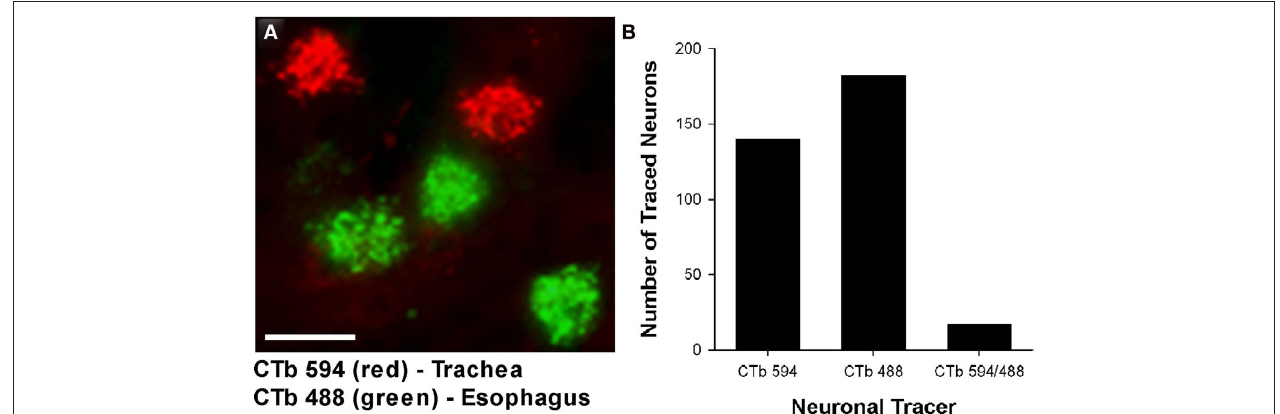
Figure 3 | (a) Representative photomicrograph showing dual retrograde labeling of neurons in the guinea pig nucleus ambiguus (nAmb) following administration of different fluorophore-conjugated cholera toxin B (CTb) subunits